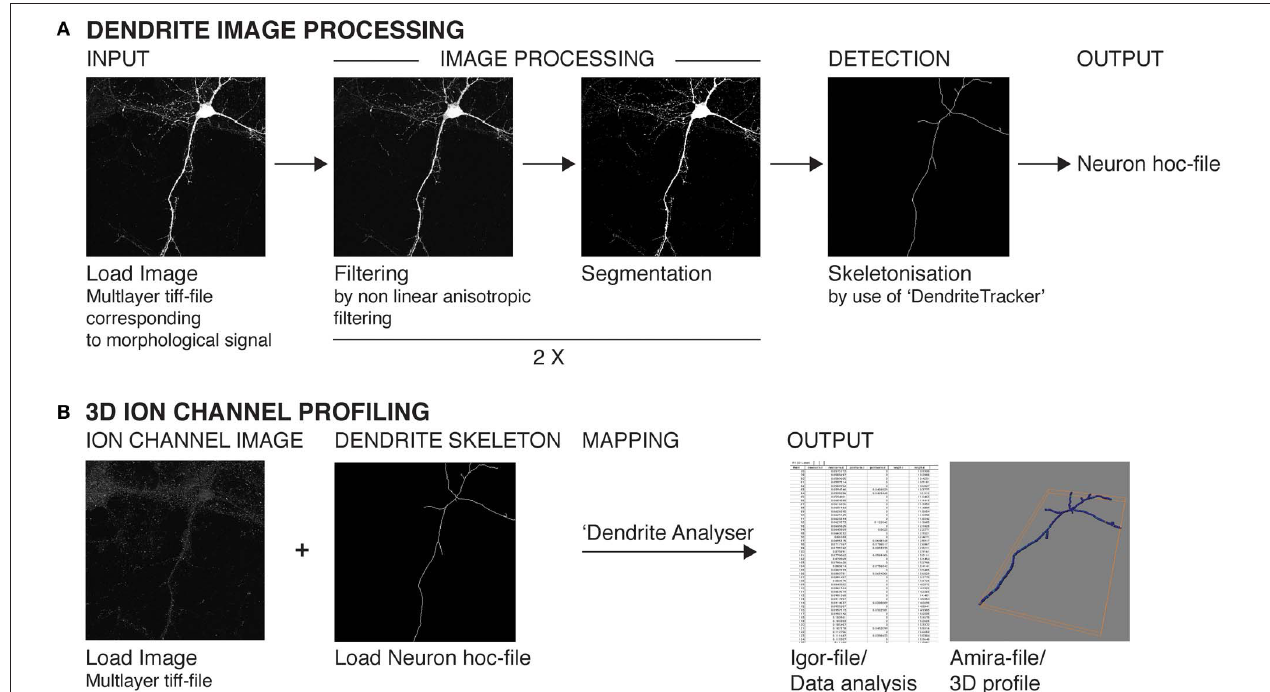
using Neuron. (B) The image stacks corresponding to ion channel signal are then subjected to 3D profiling analysis using the custom-written algorithm DendriteAnalyser . The dendritic skeleton (Neuron hoc-file) serves as reference for the 3D coordinates for fluorescent intensity calculations. The resulting analysis is written to Amira mesh and Igor Pro wave format. All confocal images stacks are converted to multi-layer tiff-files in 8-bit format prior to